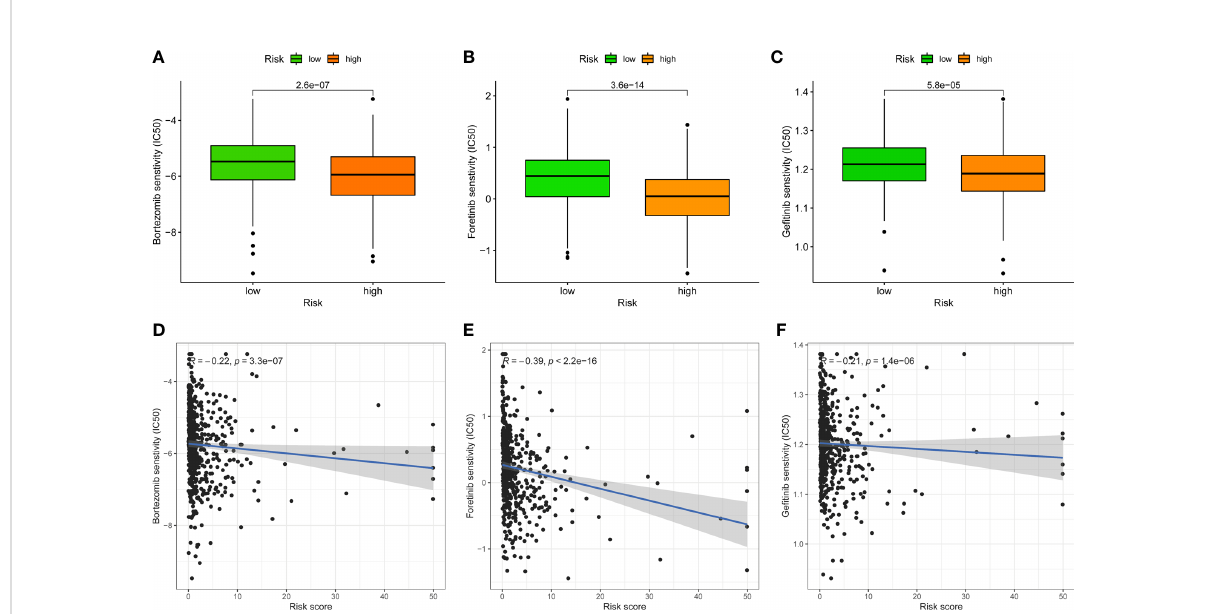
FIGURE 7 Effect of FAMGs-based risk signature in targeted UCEC therapy. (A – C) Comparation of therapeutic sensitivity between low- and high-FAMGs groups. (D – F) Relationship of risk score and estimated IC50 value. FAMGs: fatty acid metabolism-related genes. UCEC: Uterine corpus endometrial carcinoma. IC50: half-maximal inhibitory concentration.